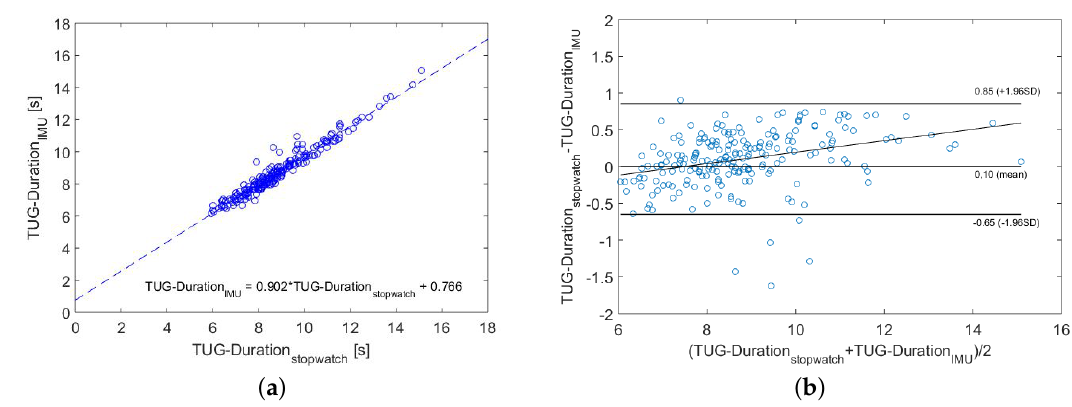
Figure 8. Comparison between stopwatch and IMU measurements. The dashed line represents the linear regression line and corresponds to the stated equation in ( a ). The Bland–Altman plot and its characteristic values are shown in ( b ). ( a ) Correlation analysis; ( b ) Bland–Altman plot.